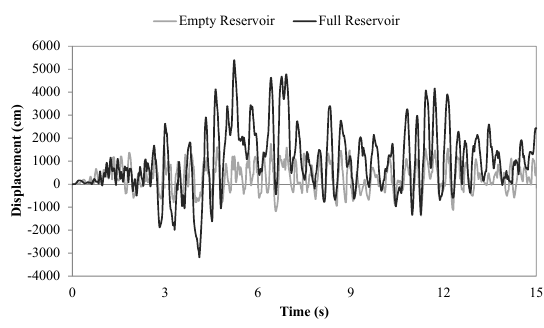
Fig. 25. The maximum principle stress components in VII-VII section.